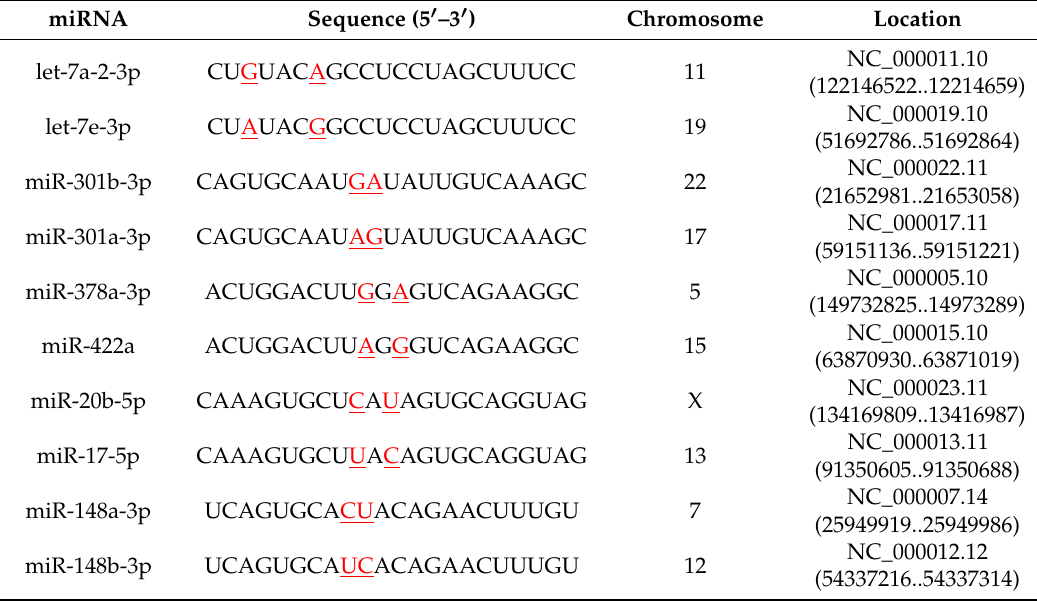
Table 2. Examples of isomeric human microRNA that have high sequence similarities, and their gene location within the human